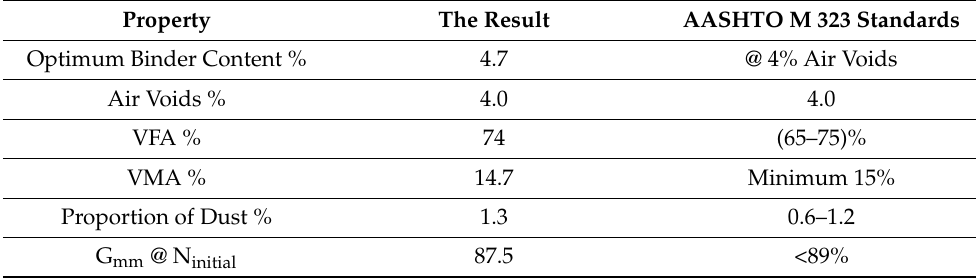
Table 17. The volumetric properties at the optimum Binder content.